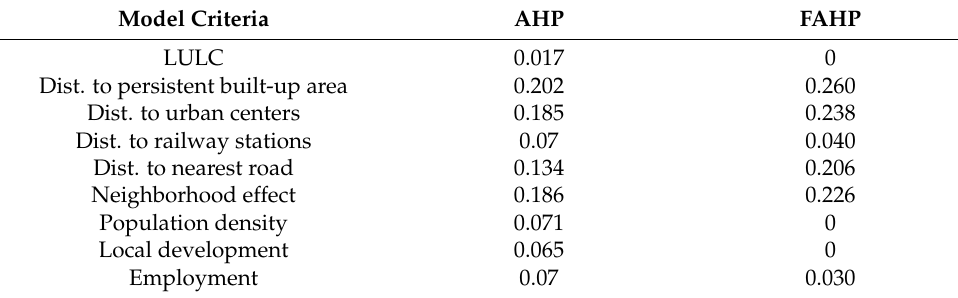
Table 5. Weights of the selected criteria based on AHP and FAHP